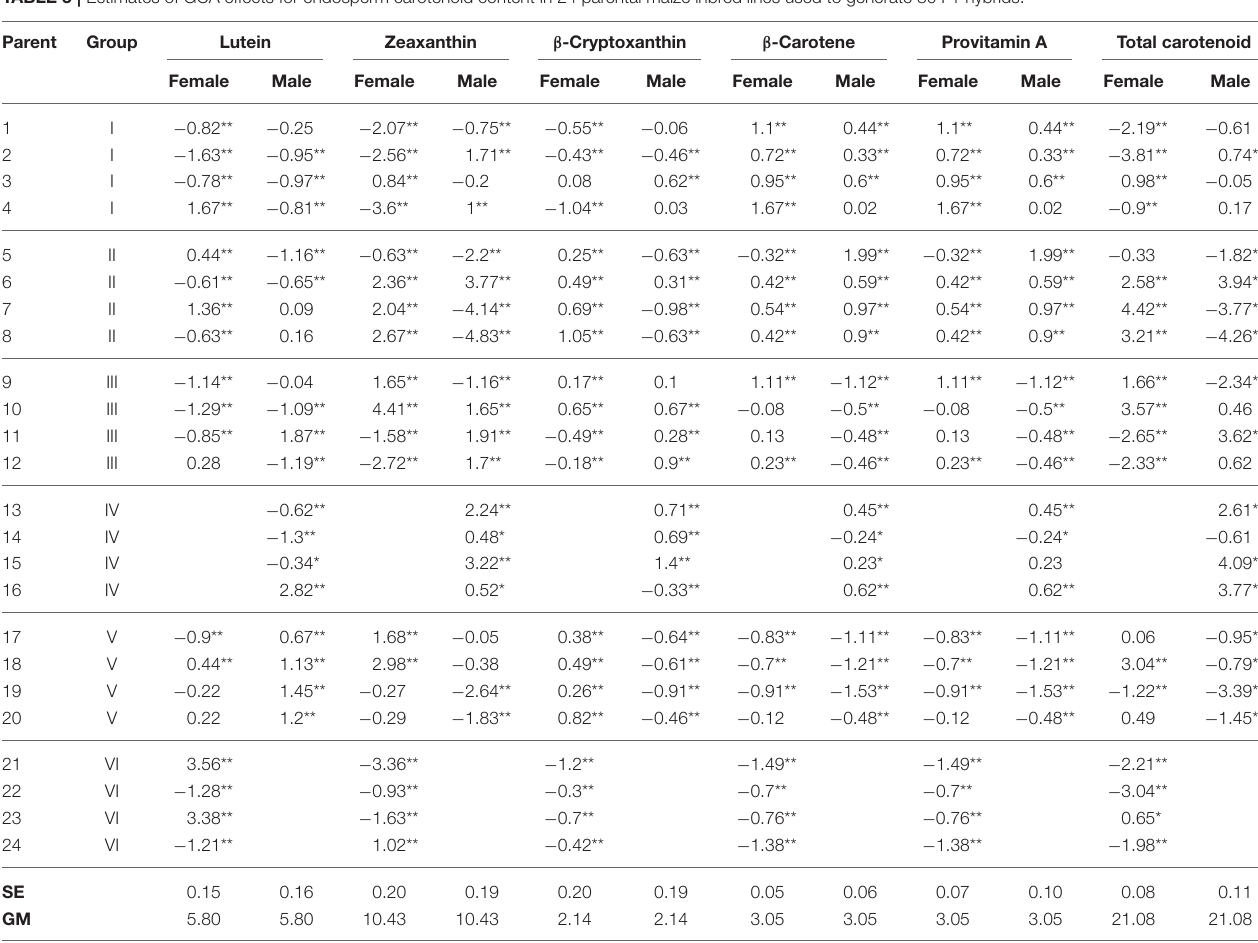
TABLE 3 | Estimates of GCA effects for endosperm carotenoid content in 24 parental maize inbred lines used to generate 80 F1 hybrids.